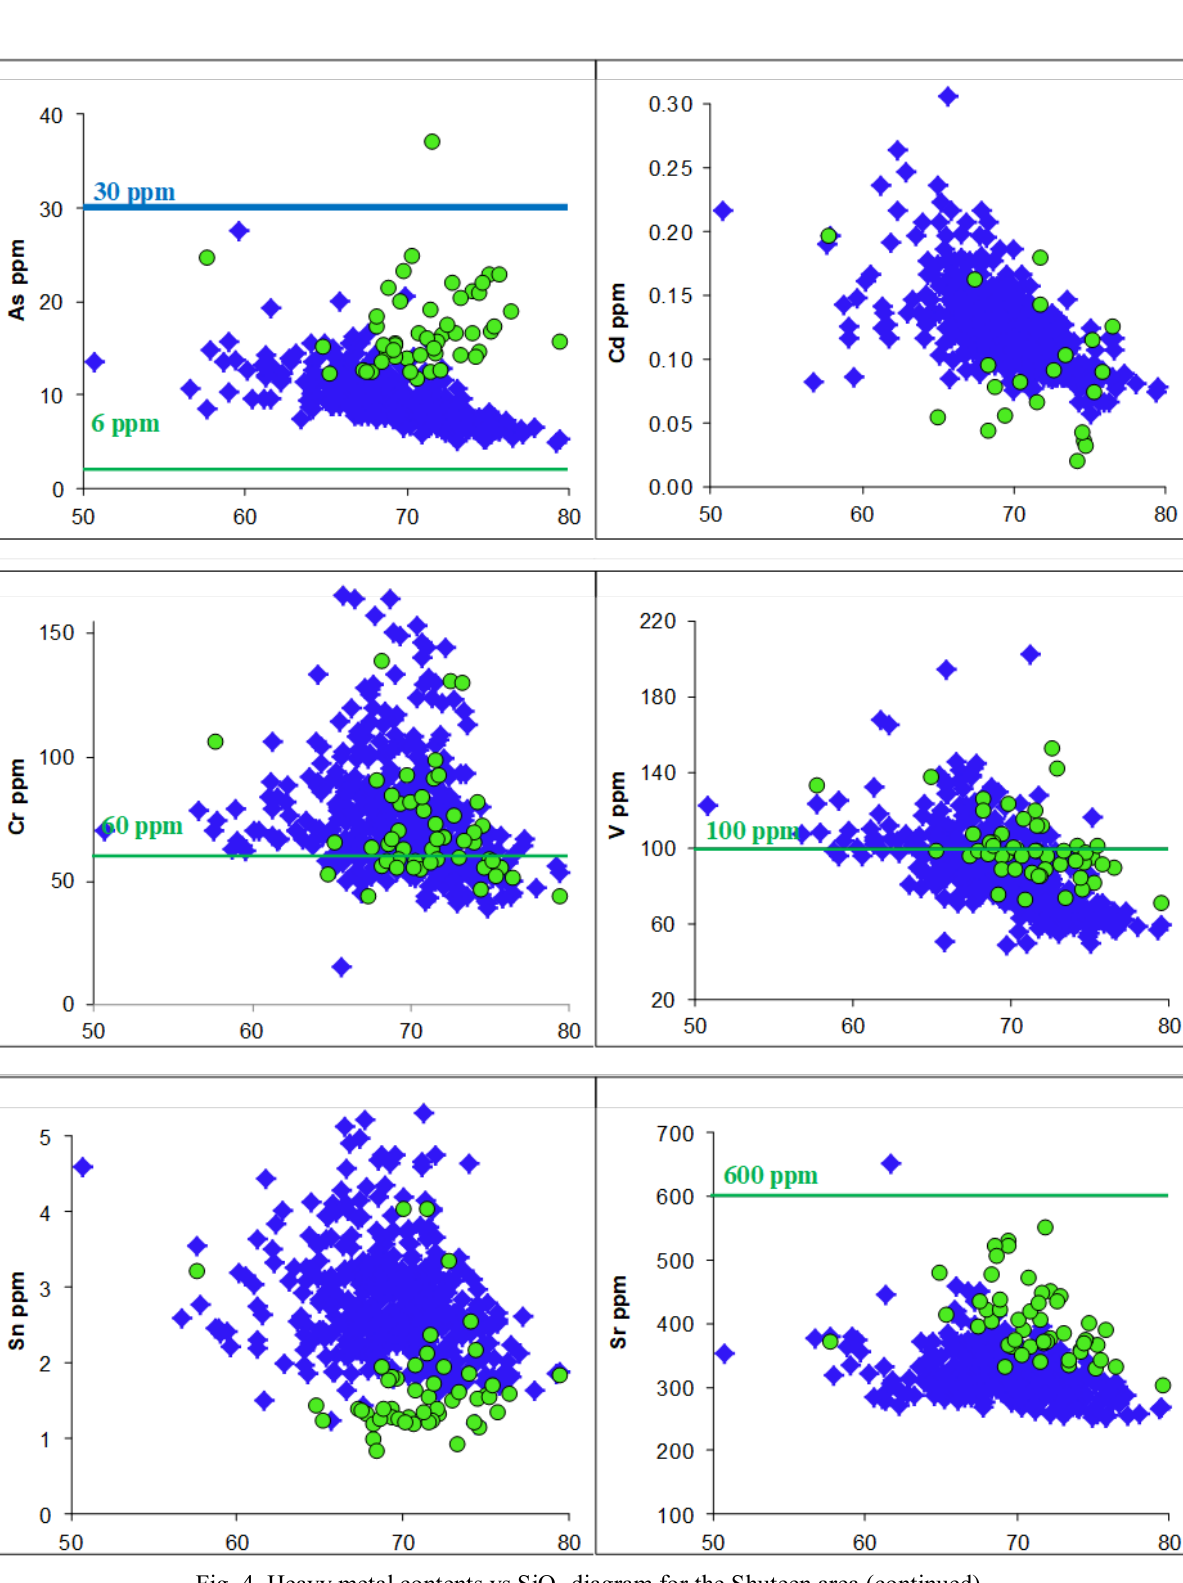
diagram for the Shuteen area 2